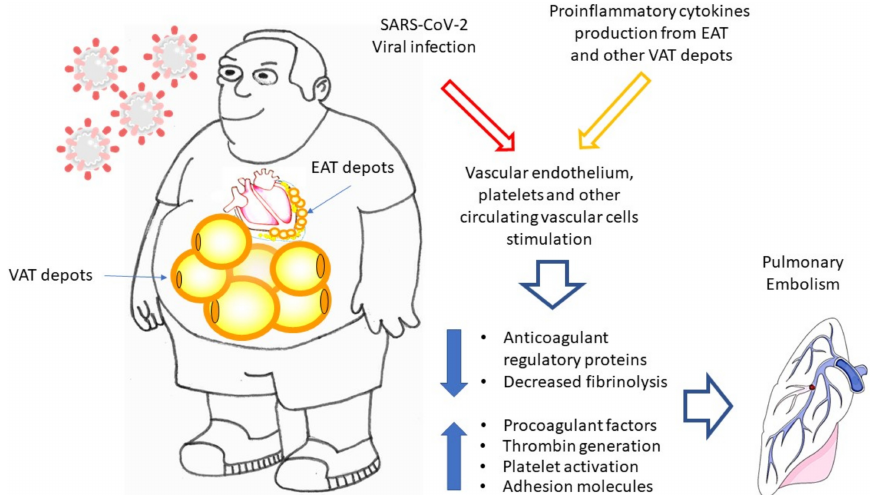
Figure 2. Hypothesis of the pathogenic role of epicardial and visceral adipose tissue on pulmonary embolism in COVID-19